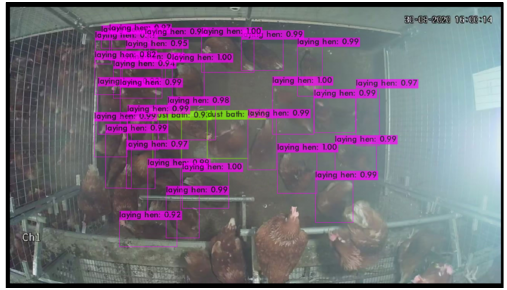
Figure 5. Object-detection classification performed on an image of the validation set using YOLOv4.